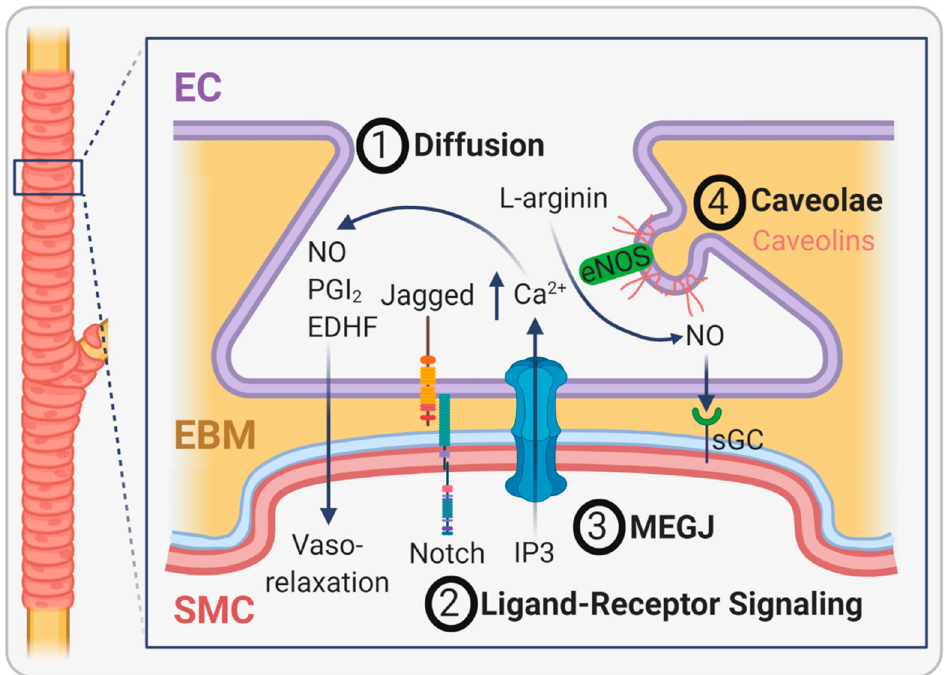
Figure 5. The role of the endothelial basement membrane (EBM) in the interaction of endothelial cells (EC) with vascular smooth muscle cells (SMC). The EBM separates EC from SMC in large vessels. Communication between EC and SMC takes place at myoendothelial junctions through different mechanisms. First, gases like nitric oxide (NO) and small molecules like prostacyclin (PGI 2 ) and endothelium-derived hyperpolarizing factor (EDHF) pass the EBM by diffusion. Second, cell membrane-bound ligands (e.g., Jagged) can bind to their respective receptor in the opposing cell (e.g., Notch receptor) to induce a biological response. Third, contact-dependent myoendothelial gap junctions (MEGJ) allow the transport of specific molecules such as inositol trisphosphate (IP3). As a result, the intracellular calcium concentration in EC increases and enhances the diffusion of NO, PGI 2 , and EDHF into SMC, causing vasorelaxation. Fourth, caveolae arrange certain molecules (e.g., endothelial nitric oxide synthase (eNOS)) and its products (e.g., nitric oxide (NO)) in close proximity to its receptor soluble guanylyl cyclase (sGC) to facilitate their interaction.